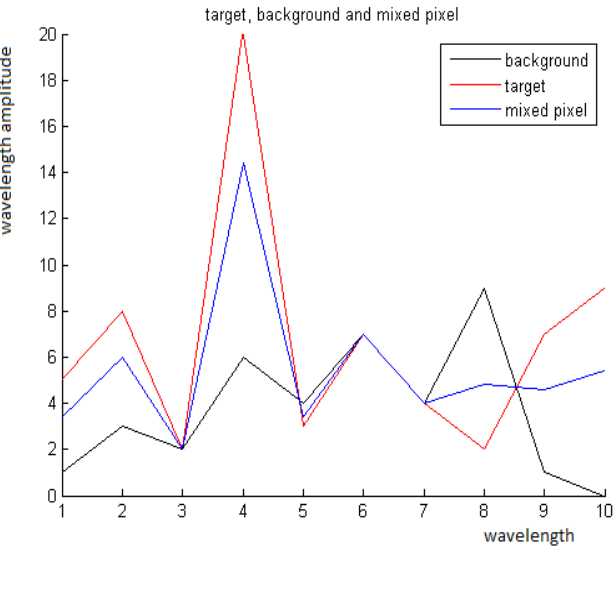
Figure 9. Random spectral vector